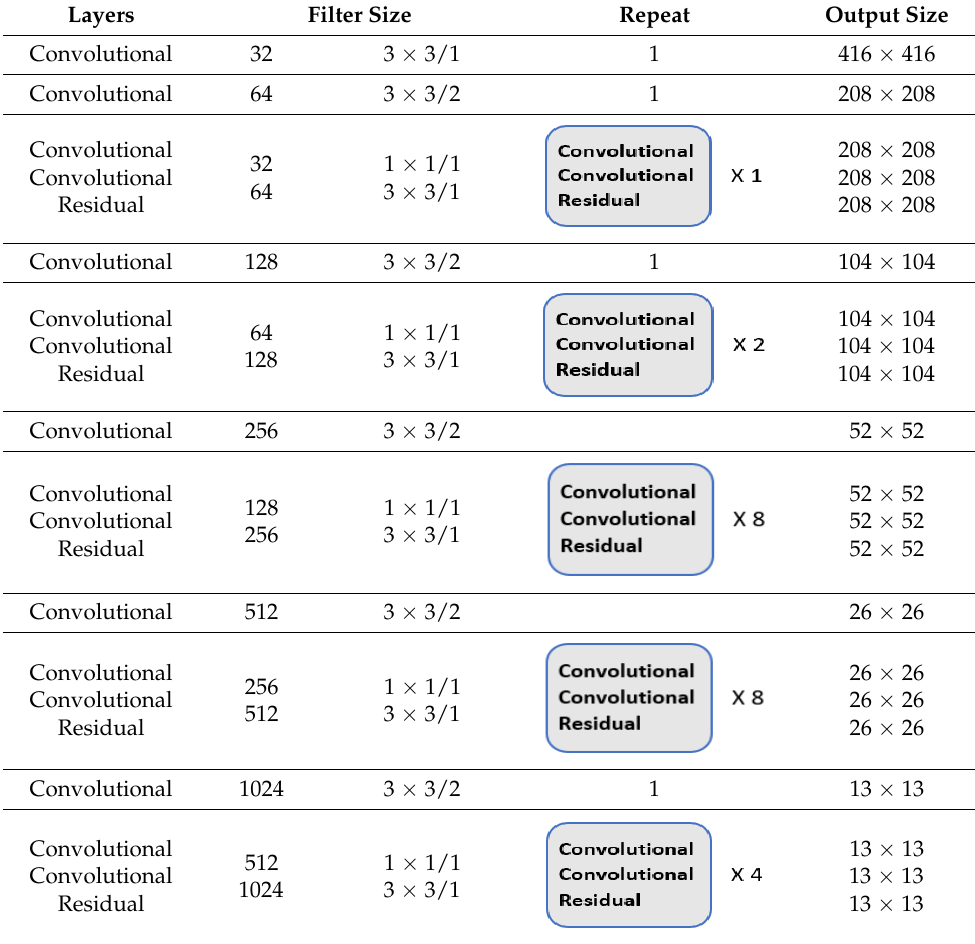
Table 2. Structure of the Darknet